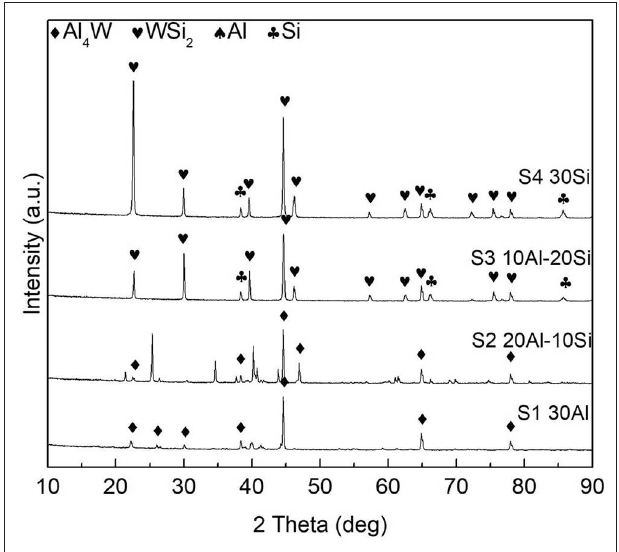
Frontiers in Materials |